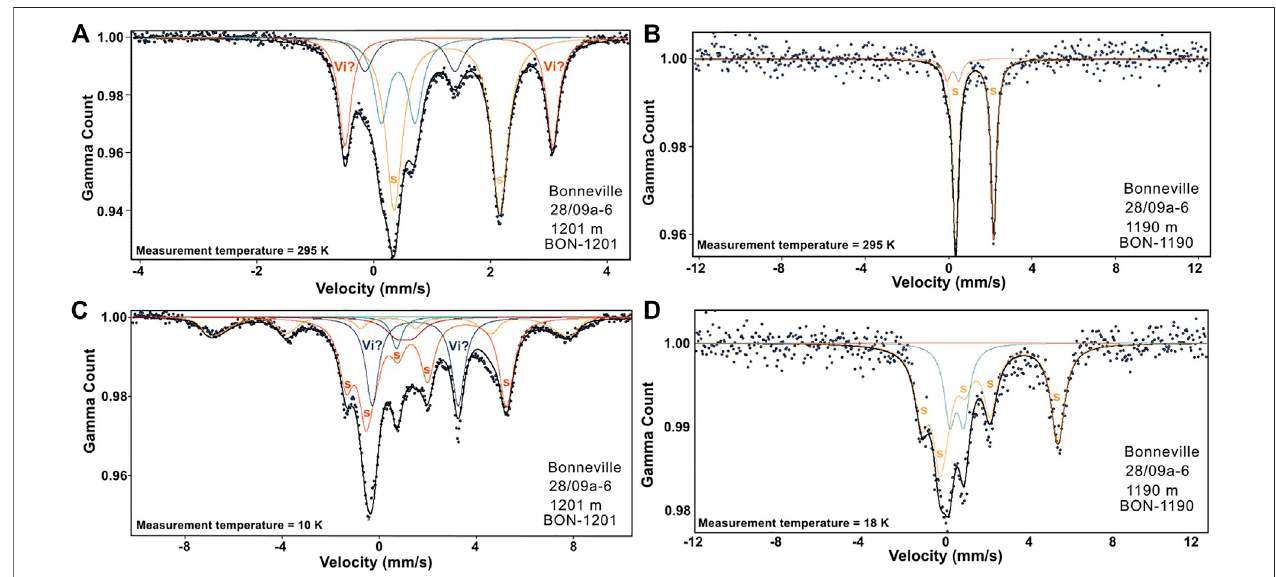
FIGURE10| Mössbauerspectrameasuredforoilreservoirsamples;BON-1201 (A,C) andBON-1190 (B,D) atroomandlow(between10and18 K)temperatures respectively. Siderite (s) is present in both samples. Vivianite (Vi) is also likely present at the OWTZ as suggested by BON 1201.